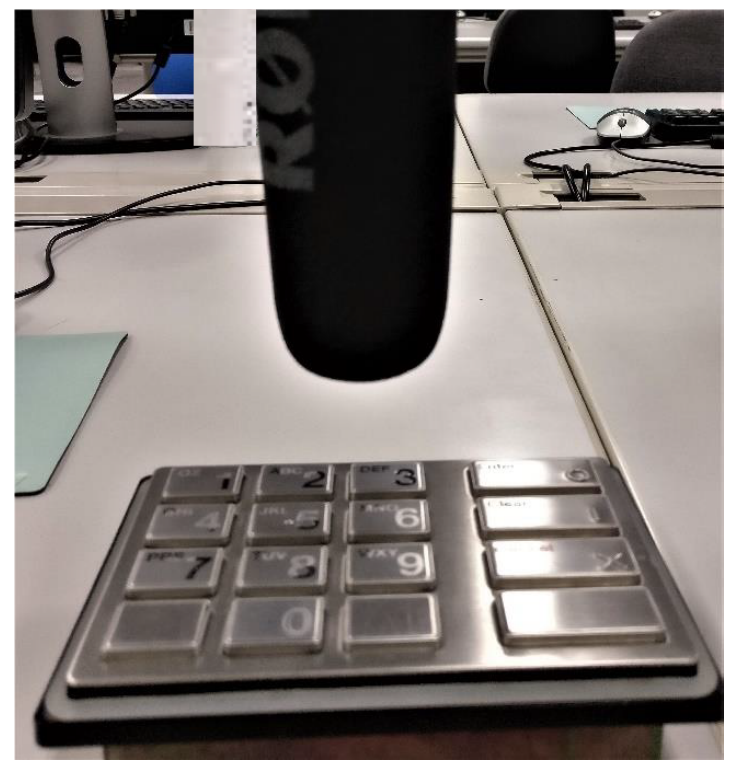
Figure 3. Experimental